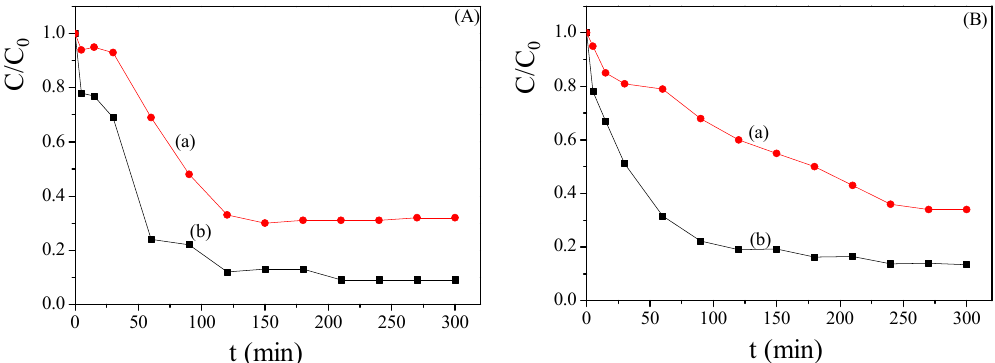
Figure 3. ( A ) Relative dye concentration, C/C 0 , as a function of reaction time for ( A ) tar and ( B ) PY for Fe 1 -NaY (a) and Fe 10 -NaY (b) catalysts: reaction conditions: 50 mg of catalyst, V Dye = 250 mL, C 0 = 30 ppm, initial pH = 3.00, C H 2 O 2 = 12 mM, T R = 40 °C.